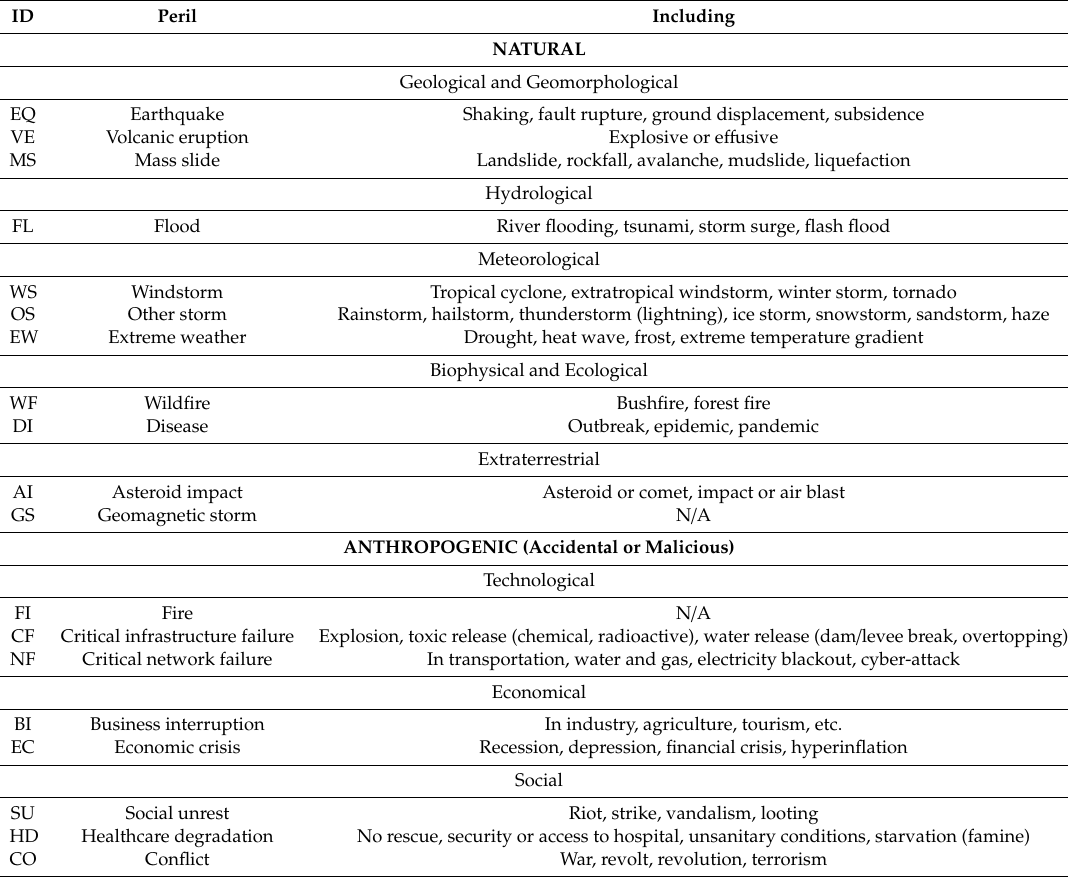
Table 1. A generic taxonomy of